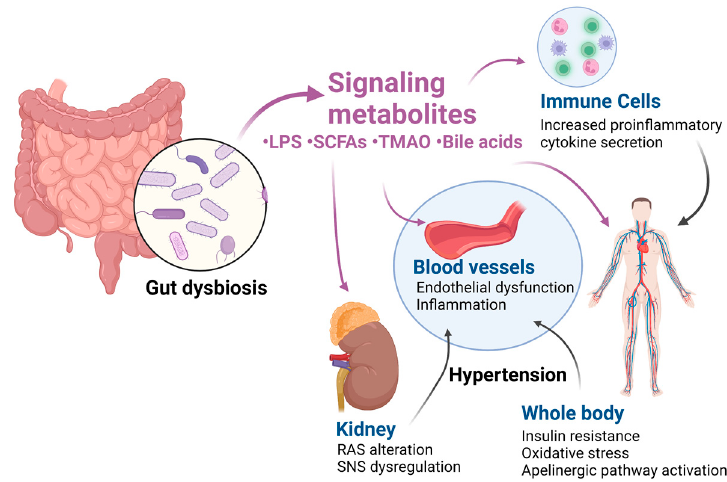
Figure 2. Proposed pathway through which perturbations in the gut microbiome may cause hyper- tension via altered signaling metabolites. LPS—lipopolysaccharide; RAS—renin–angiotensin system; SCFA—short-chain fatty acids; SNS—sympathetic nervous system; TMAO—trimethylamine